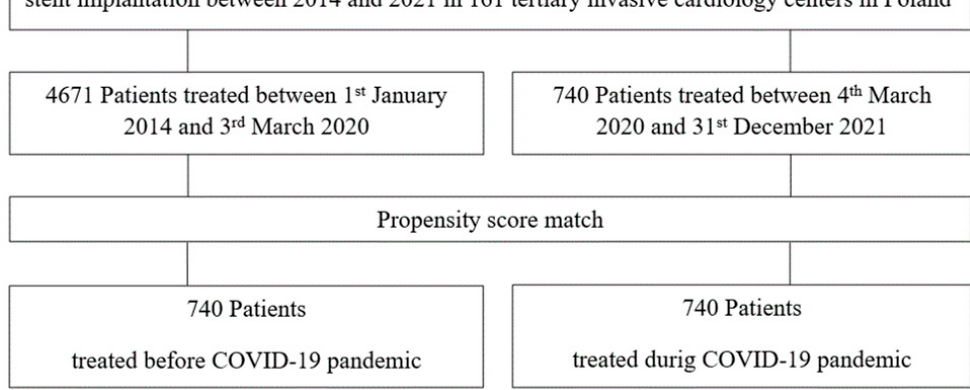
Figure 1. Flow chart of included patients. PCI—percutaneous coronary intervention; STEMI—ST- segment-elevation